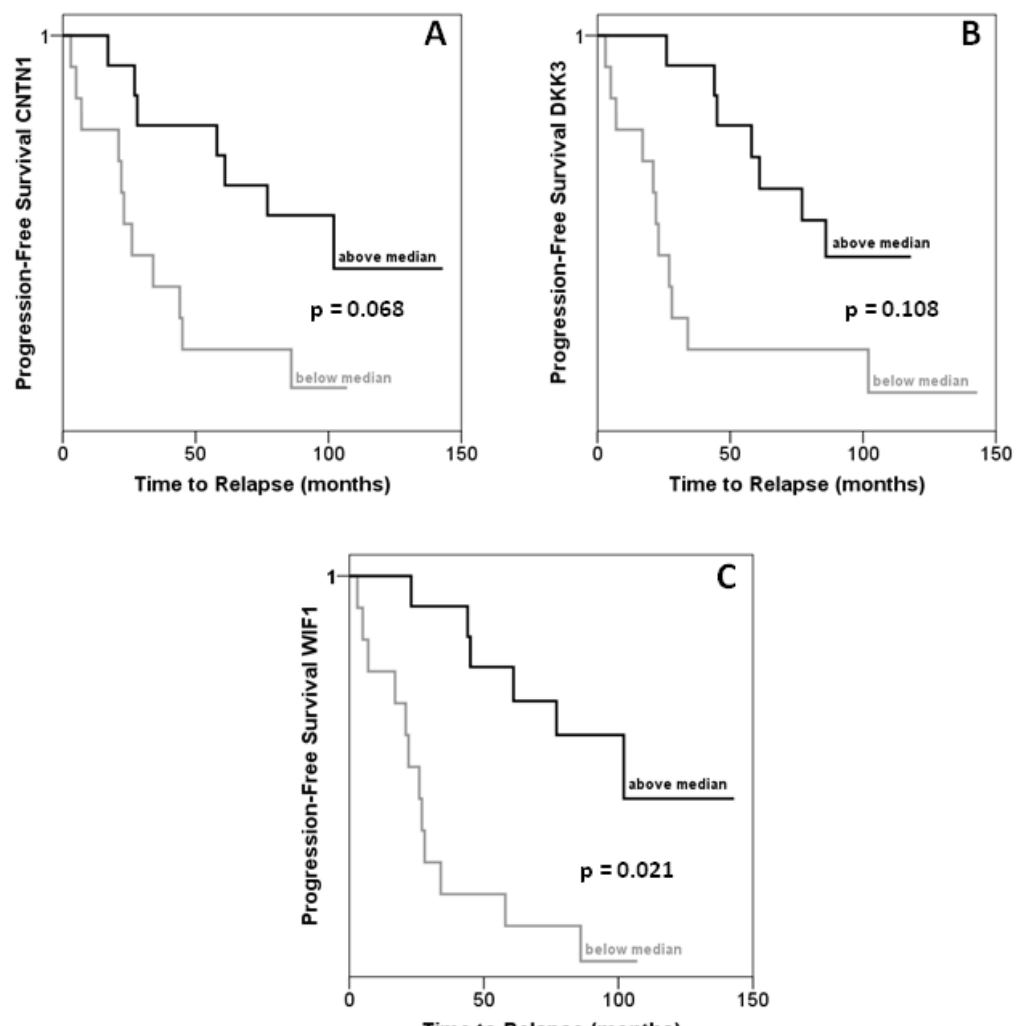
Figure 3. Relation of HOXC6 target gene expression to prostate cancer recurrence . Kaplan-Meier analysis of relation of CNTN1 ( A ), DKK3 ( B ) and WIF1 ( C ) expression to progression-free survival, measured as biochemical recurrence. Samples were stratified by median for each